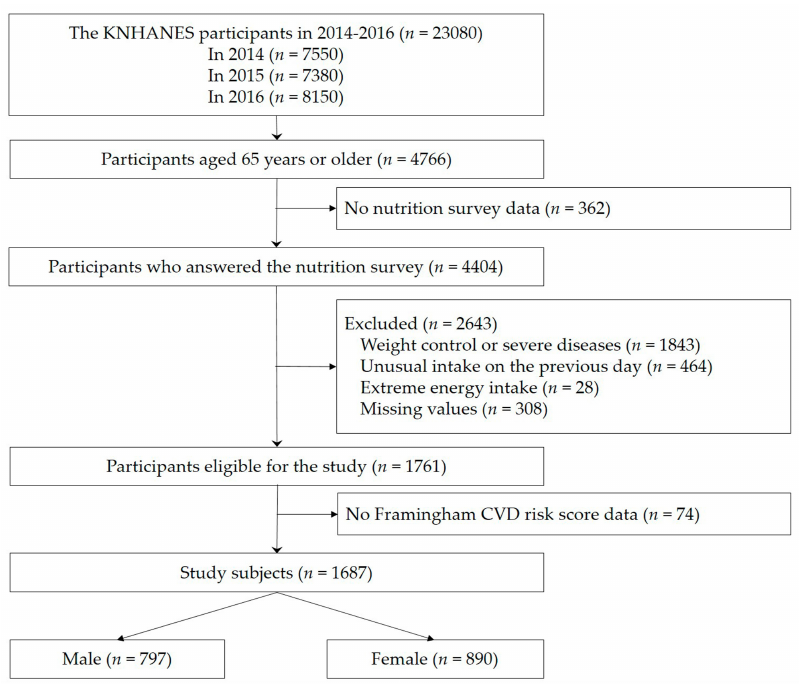
Figure 1. Flowchart of the study